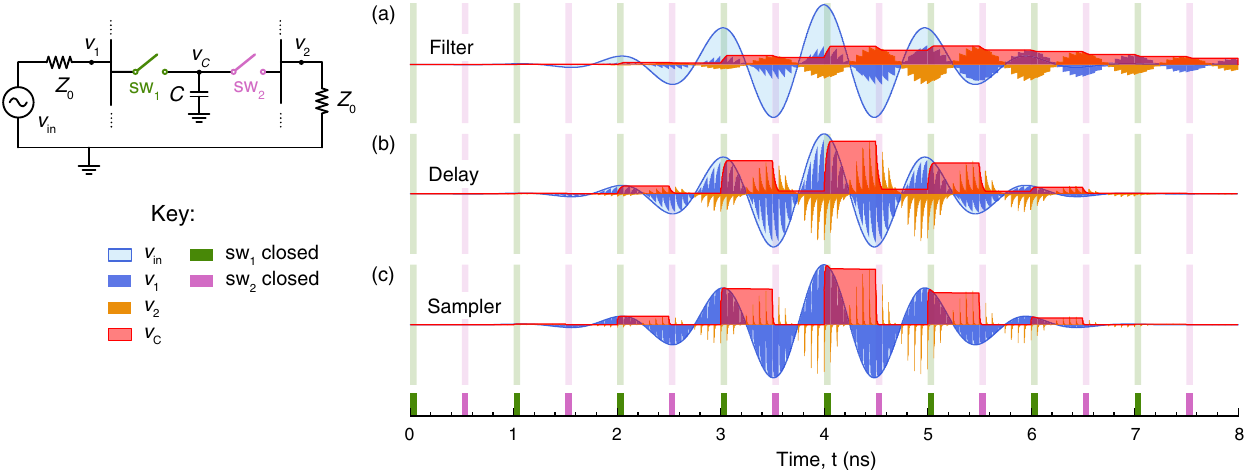
ð t Þ , in one branch of a commutated multipath network with FIG. 3. Temporal evolution of the voltage across the capacitance, v C ¼ 1 GHz, and Δ T ¼ T N ¼ 16 , f = 2 , excited by a Gaussian pulse with the center frequency f 0 ¼ 1 GHz and a duration of 4 ns. The s s tree cases shown correspond to (a) C ¼ 5 pF, at which the network operates as a high- Q filter, (b) C ¼ 0 . 5 pF, when the network acts as a broadband delay element, and (c) C ¼ 0 . 1 pF, for which the circuit operates a sampling network. Green and pink bars indicate time intervals when the input and output switches, respectively, in the first branch are closed. The analysis is performed using Keysight ADS